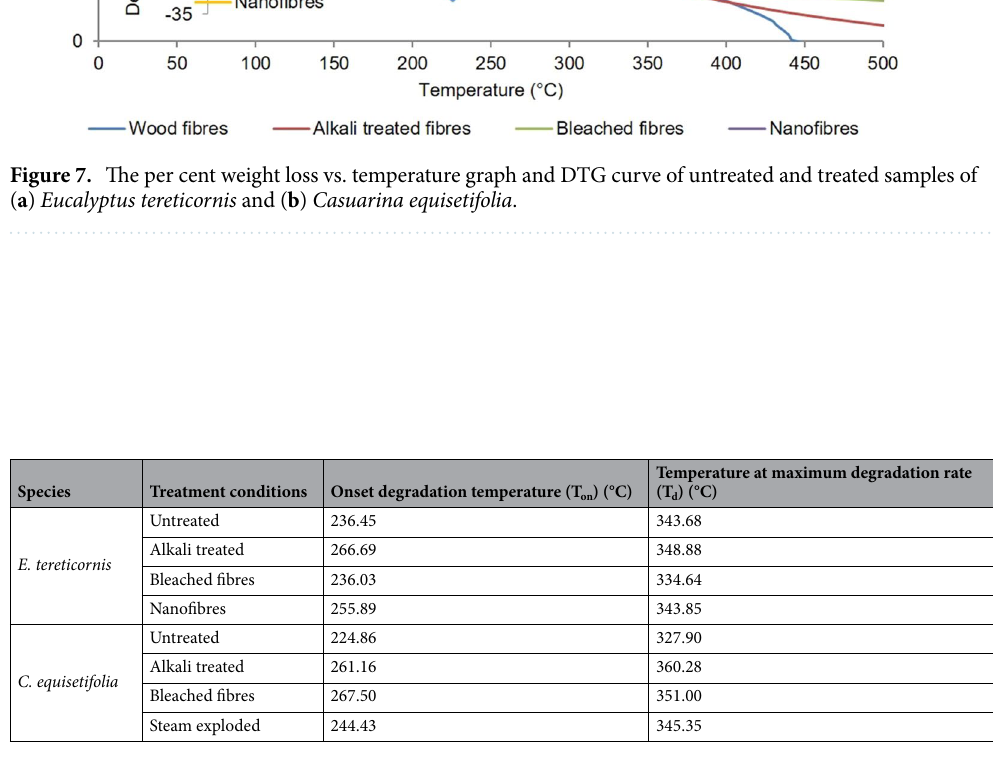
Table 3. Onset degradation temperature (T on ) and temperature at maximum degradation rate (T d ) of untreated and treated fibres of E. tereticornis and C. equisetifolia .